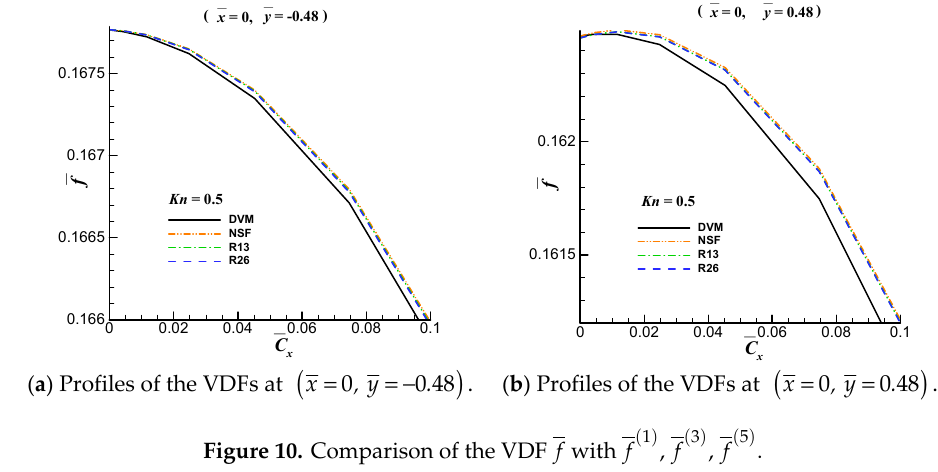
Figure 10. Comparison of the VDF f with f